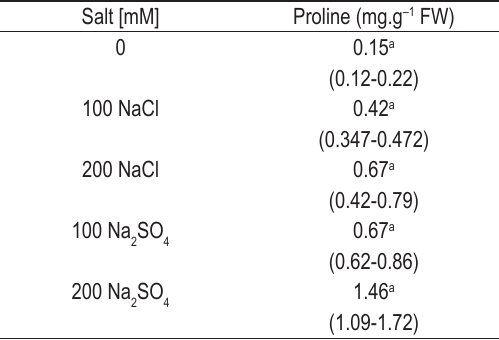
Table 3. Changes in proline concentration (µmol.g –1 DW) in the aquatic fern Salvinia auriculata subjected to salt stress induced by NaCl and Na refer to statistical difference between the control and all saline